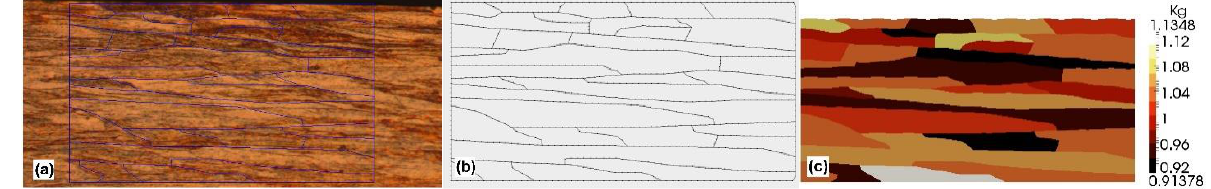
Figure 5. Stages of preparing a numerical model of a representative volume element: ( a ) processing of microstructure image and generation of grain boundaries; ( b ) generated BEM grid; ( c ) generated BEM grid with artificial initial roughness and distribution of the Kg parameter.